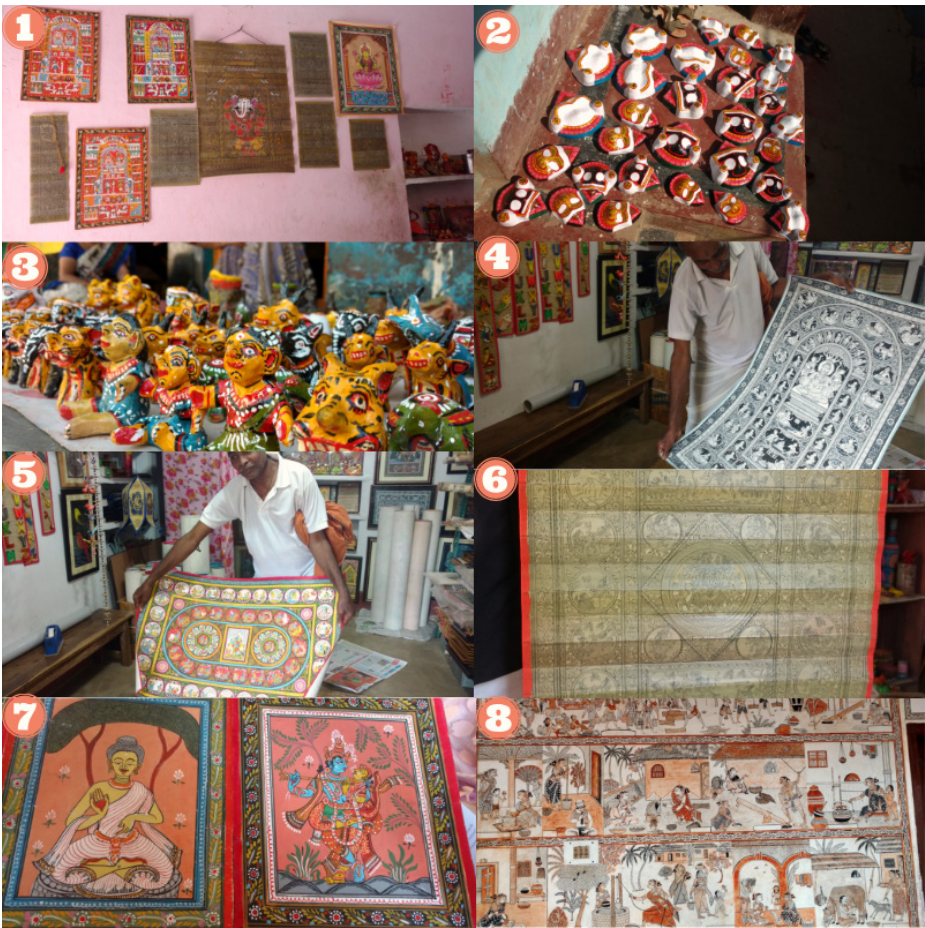
Figure 2. Collection of traditional patta paintings (source: created by authors)